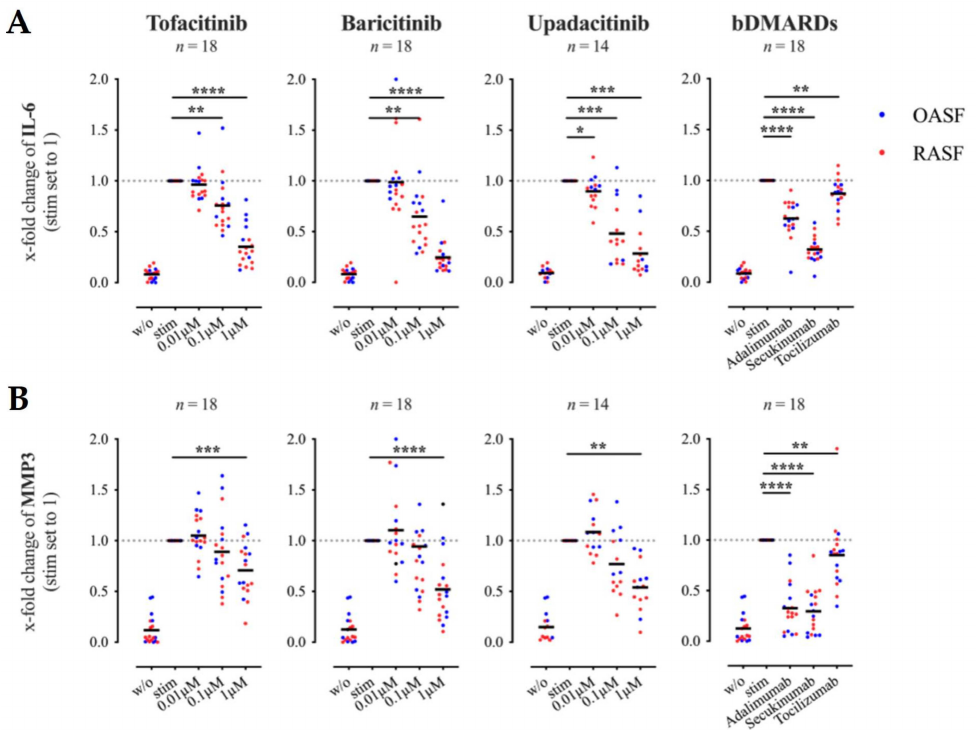
Figure 1. Effects of tofacitinib, baricitinib, upadacitinib and biologic disease modifying anti-rheumatic drugs (bDMARDs) on interleukin (IL)-6 ( A ) and matrix metalloproteinase (MMP)3 ( B ) secretion in SF-Th cell co-cultures. Synovial fibroblasts (SF) from rheumatoid arthritis (RA) patients (RASF in red) or from OA patients (OASF in blue) were co-cultured with Th cells (ratio 1:5) in the presence or absence of anti-CD3/ anti-CD28 antibodies and treated with therapeutics as indicated. The concentration of IL-6 and MMP3 within co-culture supernatants harvested on day 6 was determined by enzyme-linked immunosorbent assay (ELISA). Results are presented as x-fold change with stimulated SF-Th cells set to 1 (mean concen- trations ± SEM in co-cultures of SF with stimulated Th cells: IL-6: 600.02 ± 81.47 ng/mL; MMP3: 84.79 ± 22.48 ng/mL). BDMARDs were used at a concentration of 100 µ g/mL. Data shown as grand mean, significance tested using Wilcoxon signed-rank test, p **** ≤ 0.0001, p *** ≤ 0.001, p ** ≤ 0.01, p * ≤